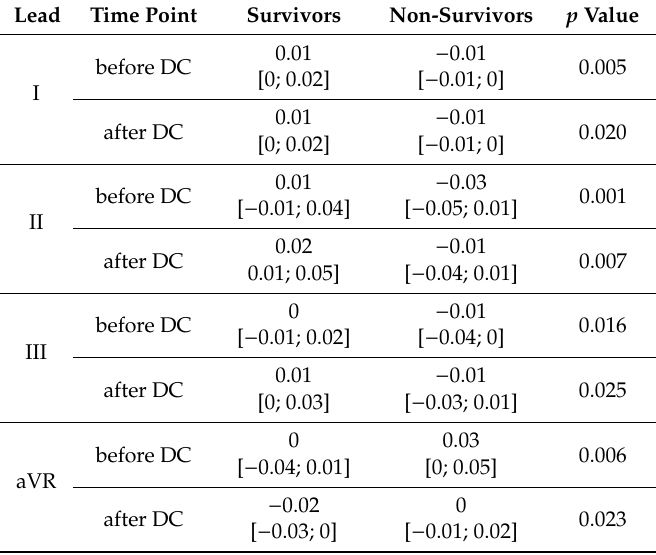
Table 3. Changes in STJ segment after compared to before decompressive craniectomy (DC) in patients who survived versus did not survive 28 days of treatment (Mann-Whitney U-test).